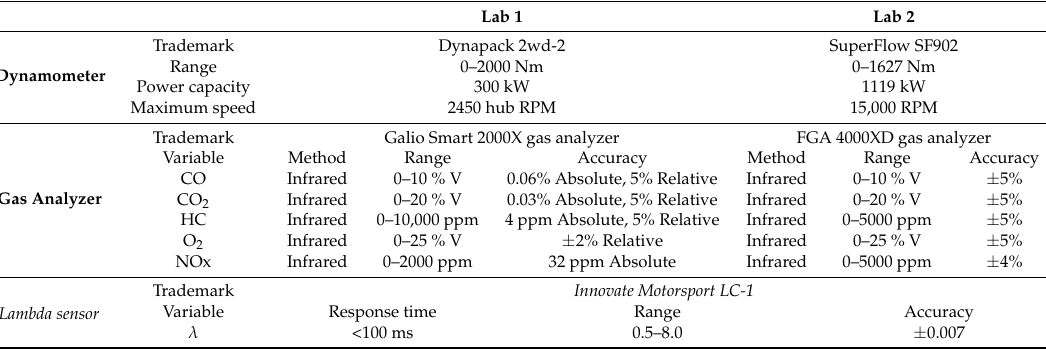
Table 4. Technical characteristics of the instrumentation used in this